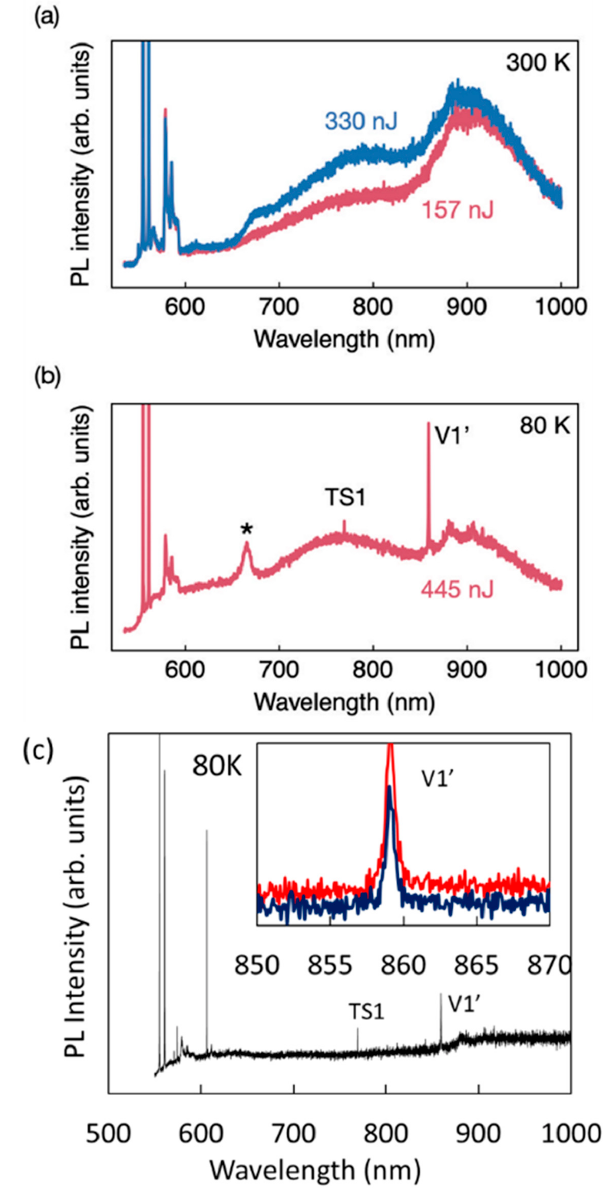
Figure 5. Spectroscopy of the ( a ) HPSI 4H-SiC laser written area corresponding to the highest energy dots of 445 and 330 nJ showing a broad emission centered at 920 nm and an emission at 770 nm. ( b ) Here, 80 K spectroscopy of a dot at 445 nJ. V 1 ′ is at 859 nm corresponding to the hexagonal ZPL of the V Si in the 4H-SiC. The emission at 769 nm shows a ZPL at low temperature, TS1, previously observed in proton irradiated 4H-SiC annealed at high temperature [45] however, the origin is unknown. A peak indicated with (*) is also unknown emission and it is due to laser irradiation. ( c ) Further, 80 K spectroscopy of the area not fabricated showing a background of the TS1 and V 1 ′ line. The V 1 ′ line was enhanced after laser fabrication as shown in the inset, where the emission in red is from the laser fabricated area. Excitation is at 532 nm, and collection is above 532 nm.